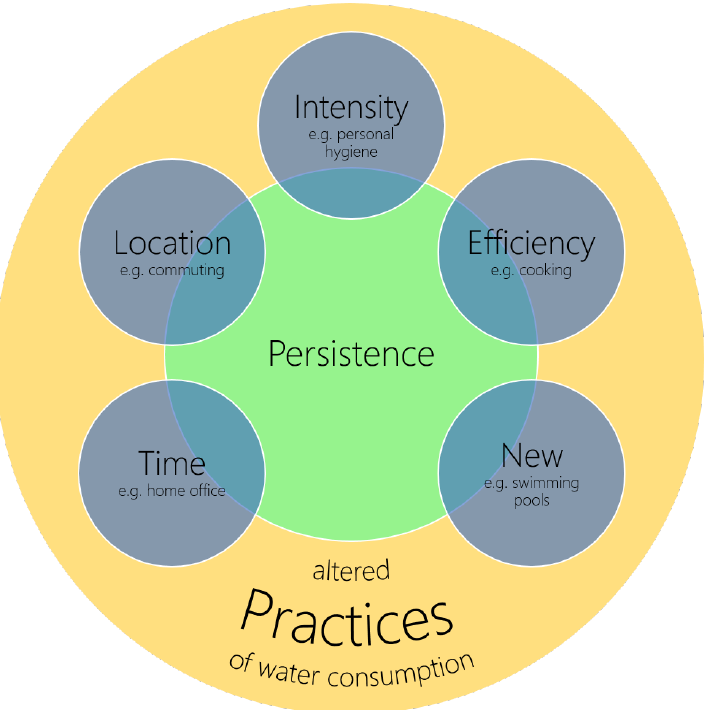
Figure 5. Overview of the different dimensions of altered practices that might have caused the increase of the observed water consumption and the outlook of a presumed persistence. It illustrates that some of the altered practices will presumably not continue in the future, but a small amount will persist when people find such adaptations favorable.